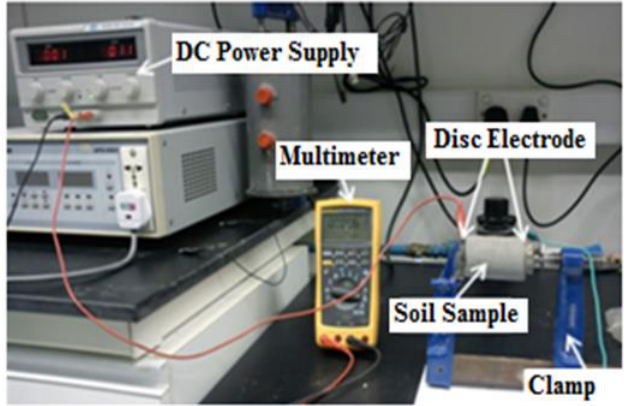
Fig. 1. Experimental arrangement for ER measurement